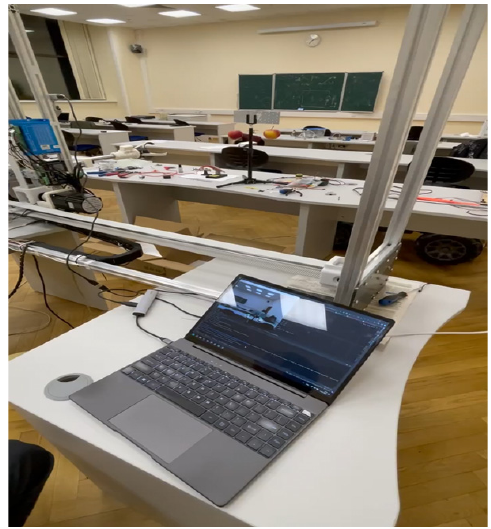
Figure 4. Manipulator with computing device and